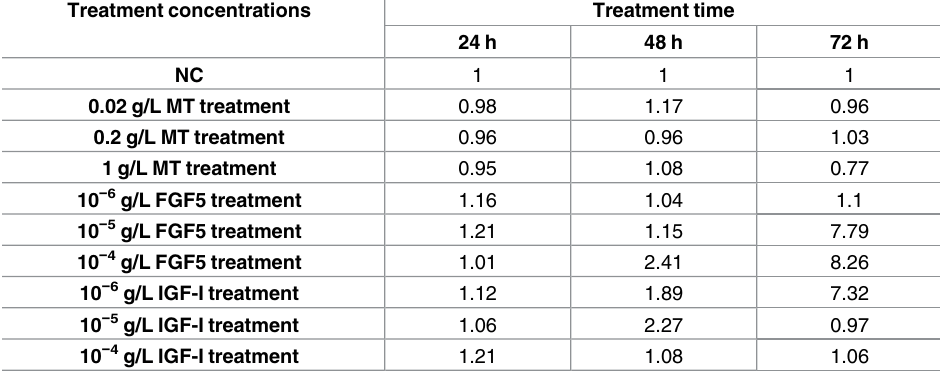
Table 4. The results of gray analysis after treatment with MT, FGF5, IGF-I in immunofluorescence detection preliminary experiment. Treatment